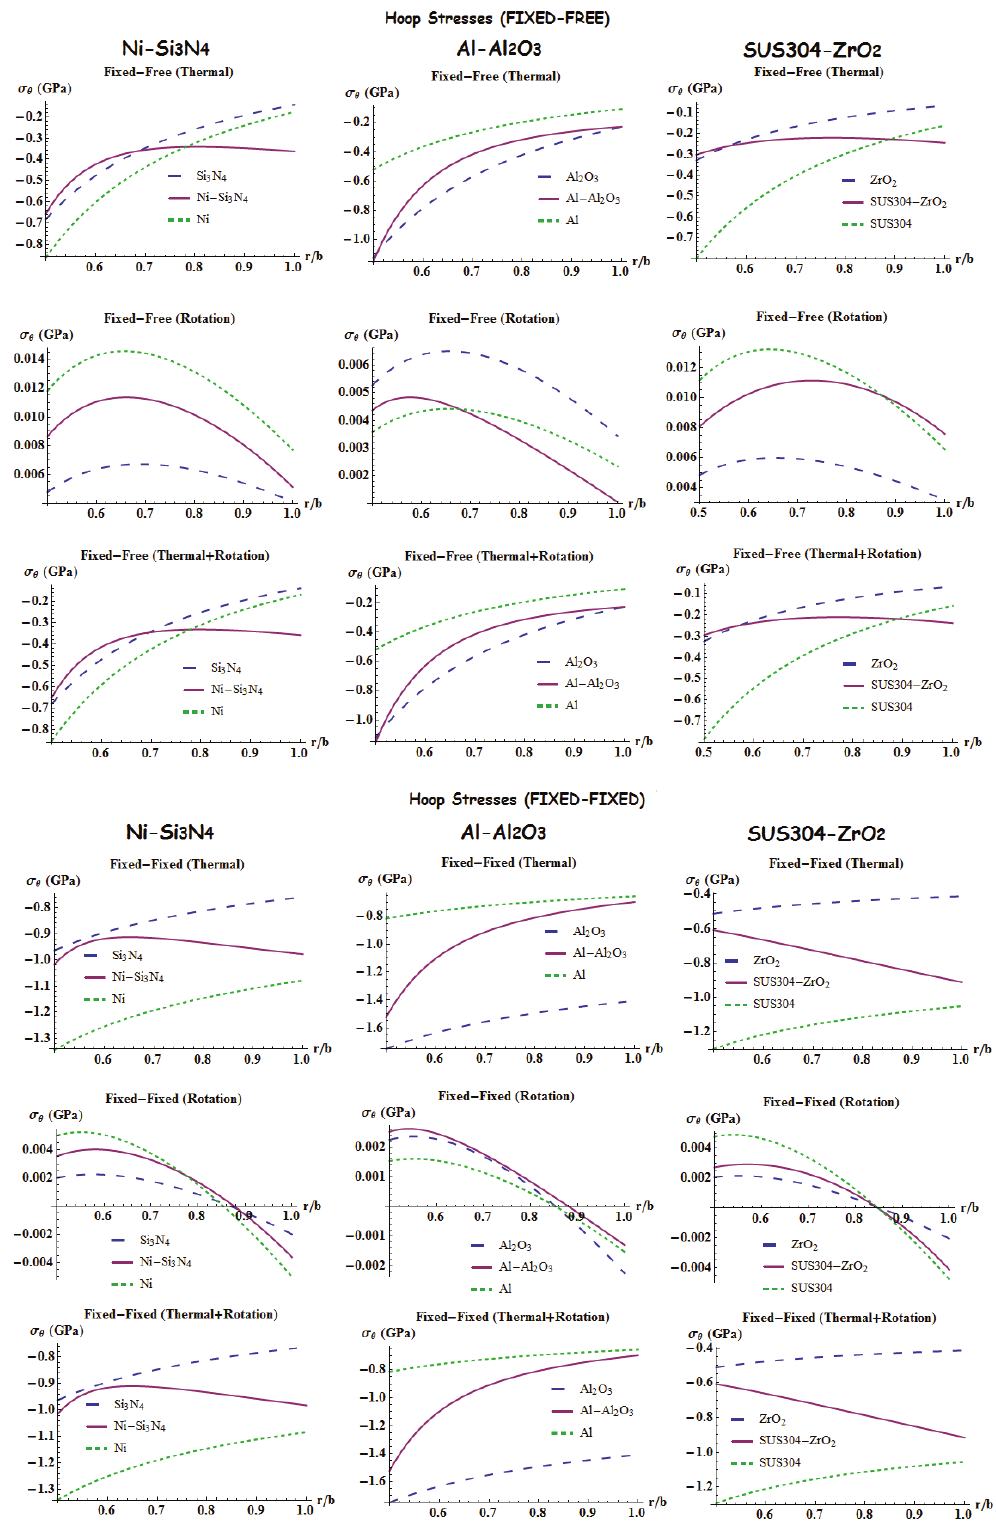
Figure 6. Variation of the hoop stresses.